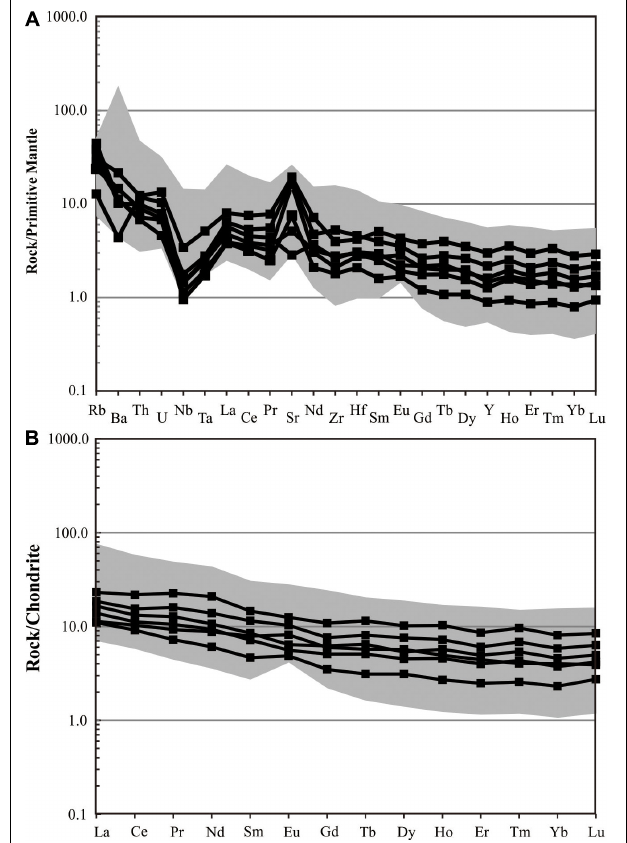
FIGURE 9 | Primitive mantle-normalized trace element patterns (A) and chondrite-normalized REE patterns (B) . Olivine gabbro normalizing values after Sun and McDonough (1989). The gray shadows show the spectrum of trace and REE elements from the Middle-Late Permian mafic–ultramafic intrusions developed in the East Kunlun Orogen (Xiong et al., 2011a; Kong et al.,